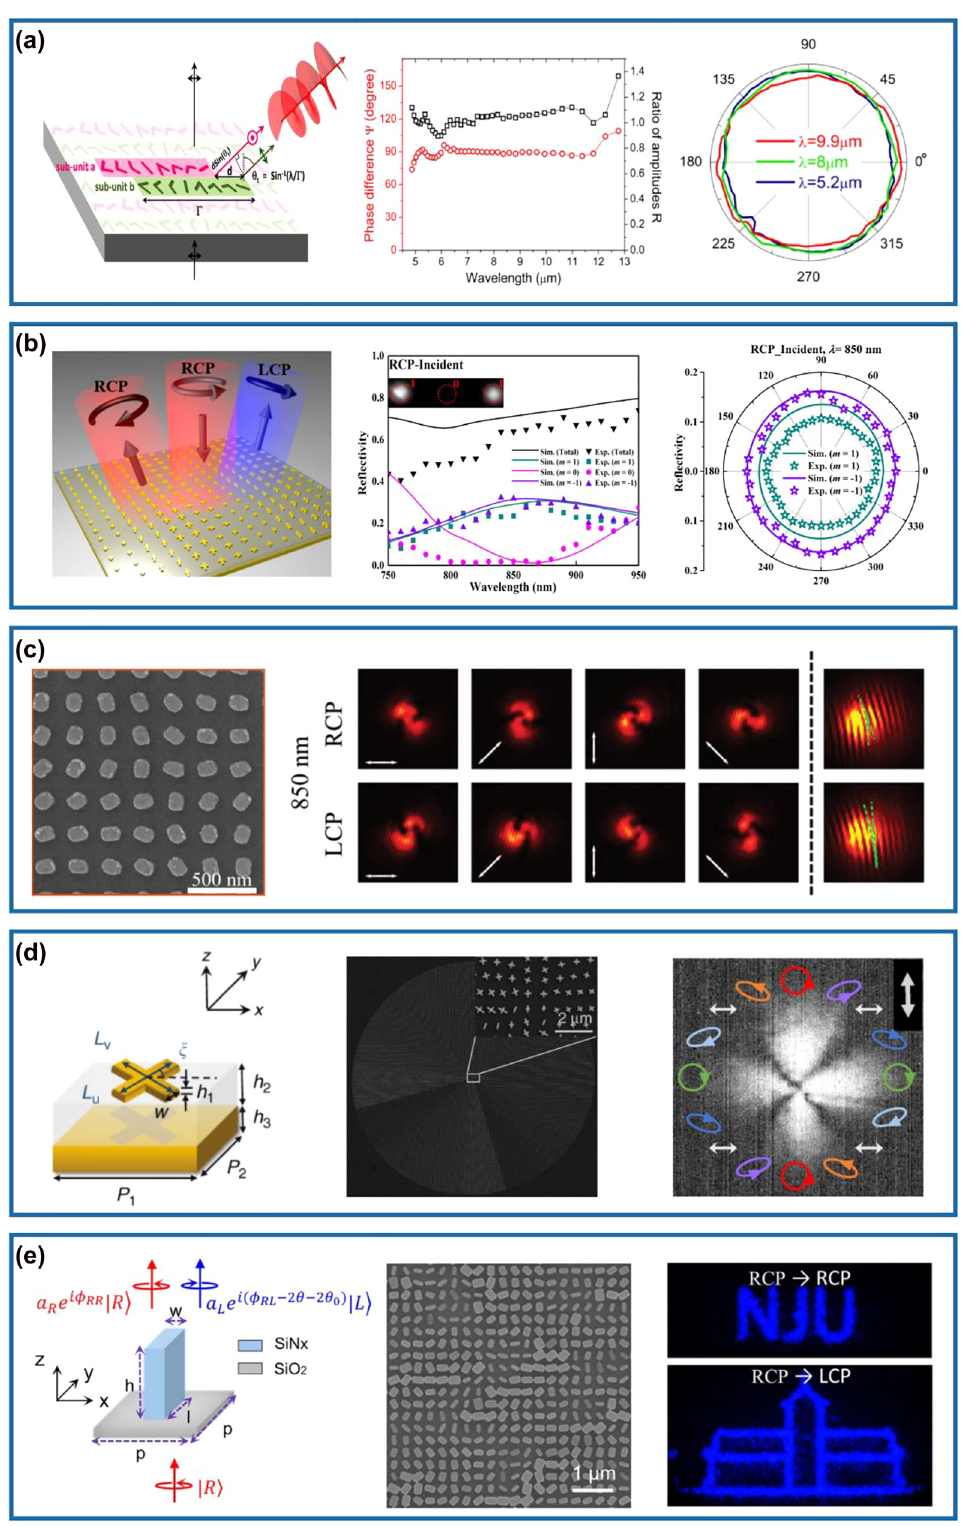
Figure 5: Multifunctional meta-QWPs. (a) Left panel: schematic of the background-free meta-QWP composed of two Au V-shaped antenna subunits. Middle panel: simulated phase difference and ratio of amplitudes between the two scattered waves from the subunits as a function of the wavelength. Right panel: measured SoPs of the extraordinary beam at wavelengths of 5.2, 8, and 9.9 µm. Reprinted from Ref.